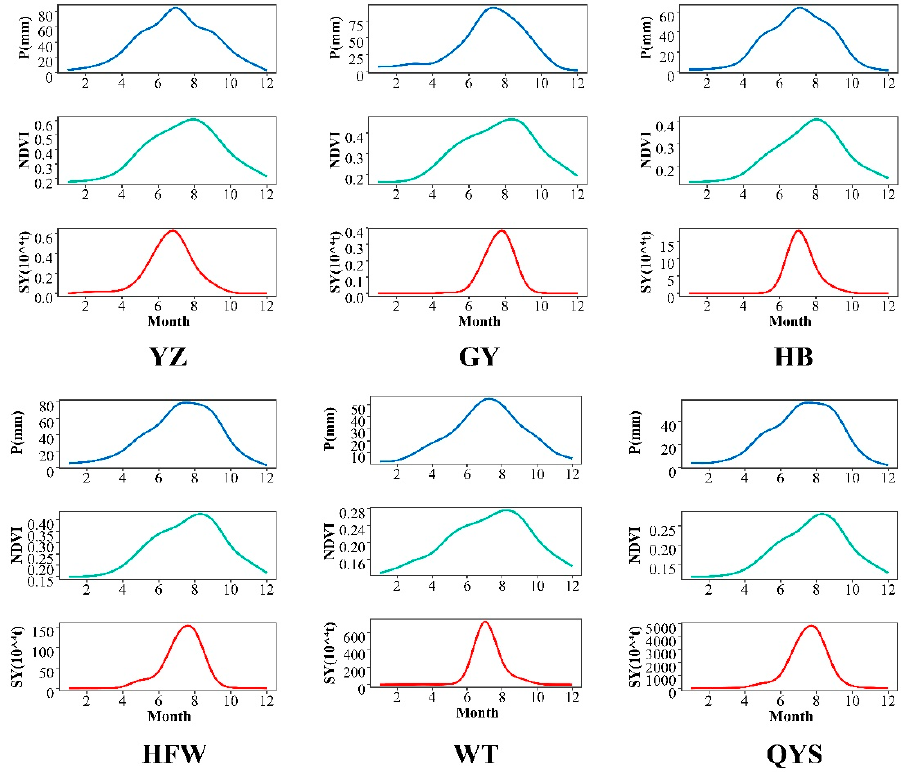
Figure 14. Mean monthly precipitation (P), NDVI, and sediment yield (SY) in 2006–2016 for six sub-basins across the QRB.